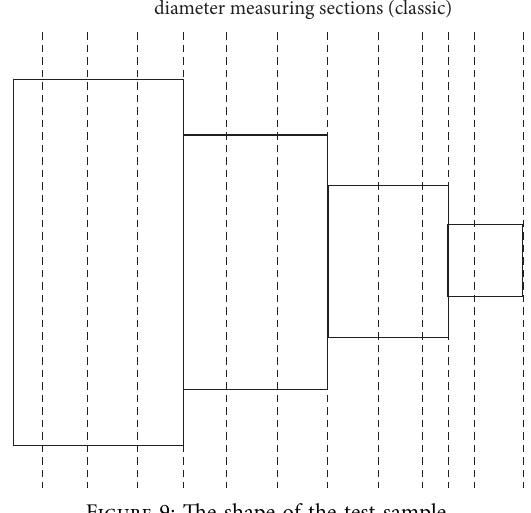
Figure 9: The shape of the test